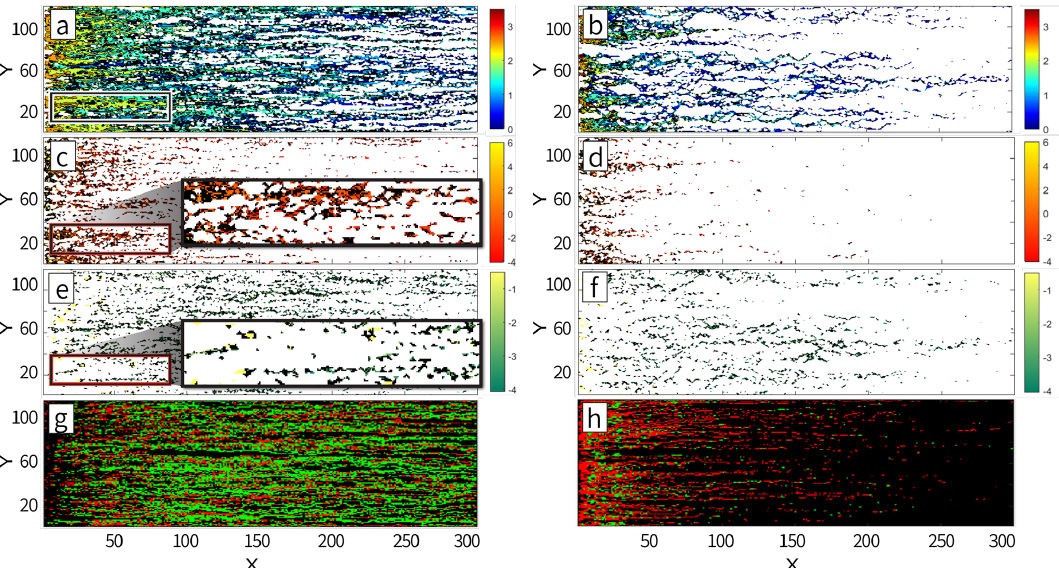
= 1 and 5, respectively, and (c– Figure 3. Heat map representing (a,b) log 10 (n R ij ) , i.e., the number of h particles visiting each cell for σ 2 0 f) relative change in hydraulic conductivity at time t = 20min (corresponding to the first pore volume) with respect to the initially generated = 1 ( c, e ) and σ 2 = 5 (d, f) . Panels (c) and (d) display positive changes in conductivity with respect to the initial field, values for σ 2 0 0 while panels (e) and (f) display negative changes in conductivity, with both positive and negative changes being represented on a log scale. Results correspond to a selected realization of the log-conductivity fields. The highlighted box illustrates the separation between regions where precipitation or dissolution take place. Panels (g) and (h) display cells associated with a net decrease (green) and increase (red) of = conductivity for cells outside (g) or within the PF (h) for σ 2 0